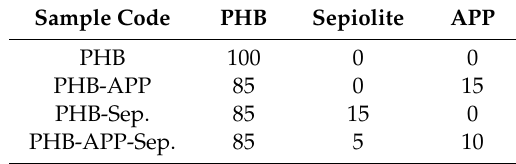
Table 2. Names and compositions of selected samples after screening study.